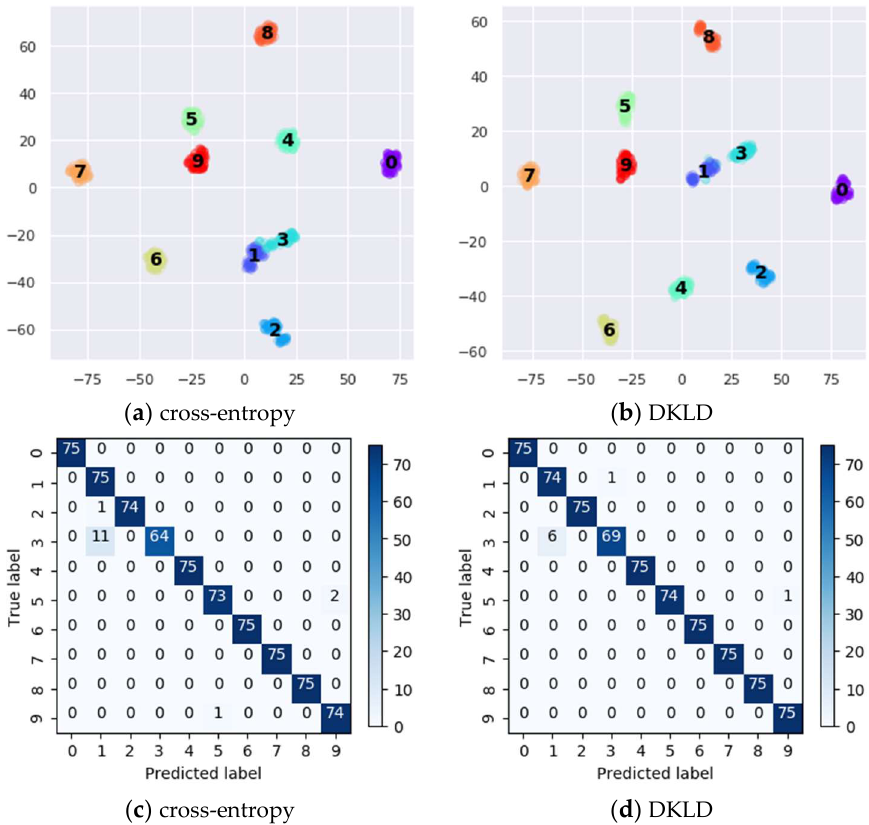
Figure 7. Results of proposed model training with different loss functions.